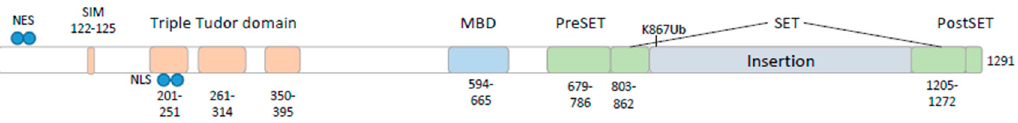
Figure 1. Protein domain structure of SETDB1. The human SETDB1 protein (1291 amino acids, 143 kDa) contains triple Tudor domains (TTDs) and a methyl-CpG binding domain (MBD) in its N -terminal part, followed by a split SET domain (pre-SET, SET, and post-SET). The TTDs bind to histone H3 tails that have been modified by K14 acetylation combined with K9 methylation. The C-terminal region containing the pre-SET, SET, and post-SET domains is responsible for H3K9 specific lysine methylation [21,24]. The SET domain of SETDB1 has a long insertion, which is monoubiquitinated by UBE2E enzymes independent of E3 ligase (on K867 in human or K885 in mouse), and this monoubiquitination highly enhances the methyltransferase activity of SETDB1 [39,40]. At the N -terminal region of SETDB1, there is a functional SUMO interacting motif (SIM) [41] in close proximity to a nuclear export signal (NES) and a nuclear localization signal (NLS) [42].